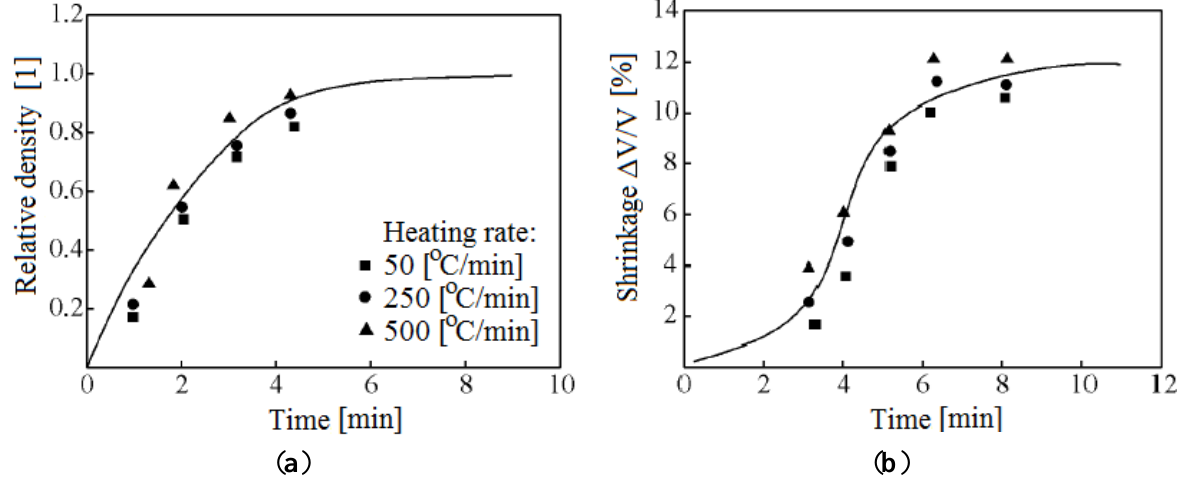
О : ( a ) at 1100 °С; and ( b ) at 1400 2 3